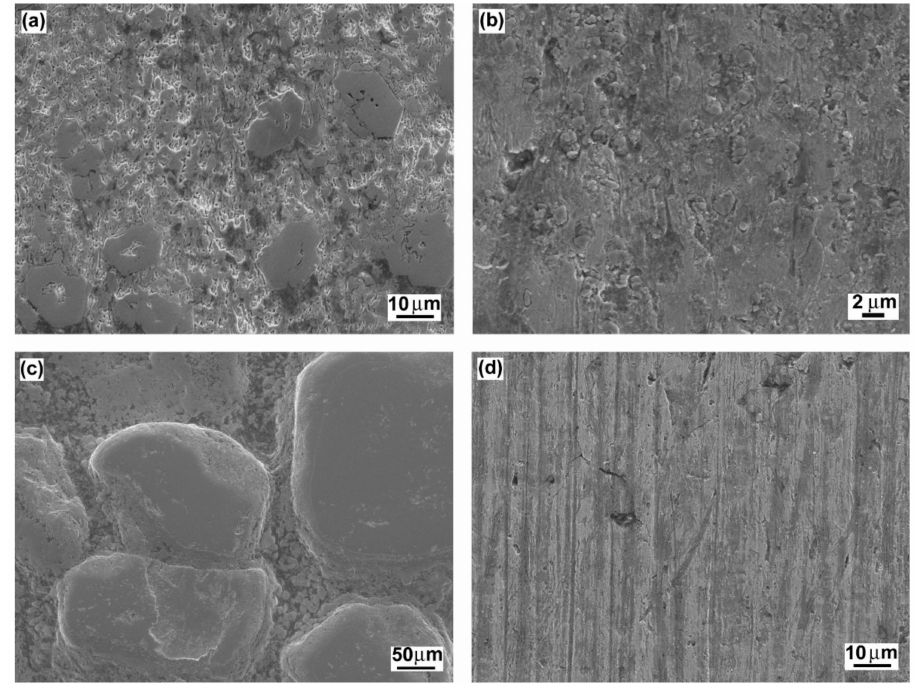
Figure 12. Typical wear mechanisms of selected hardfacings with significantly di ff ering abrasive wear resistance: “E520 RB” ( a ); “Weartrode 62” ( b ); “RD 571” ( c ); “LNM 420FM” ( d